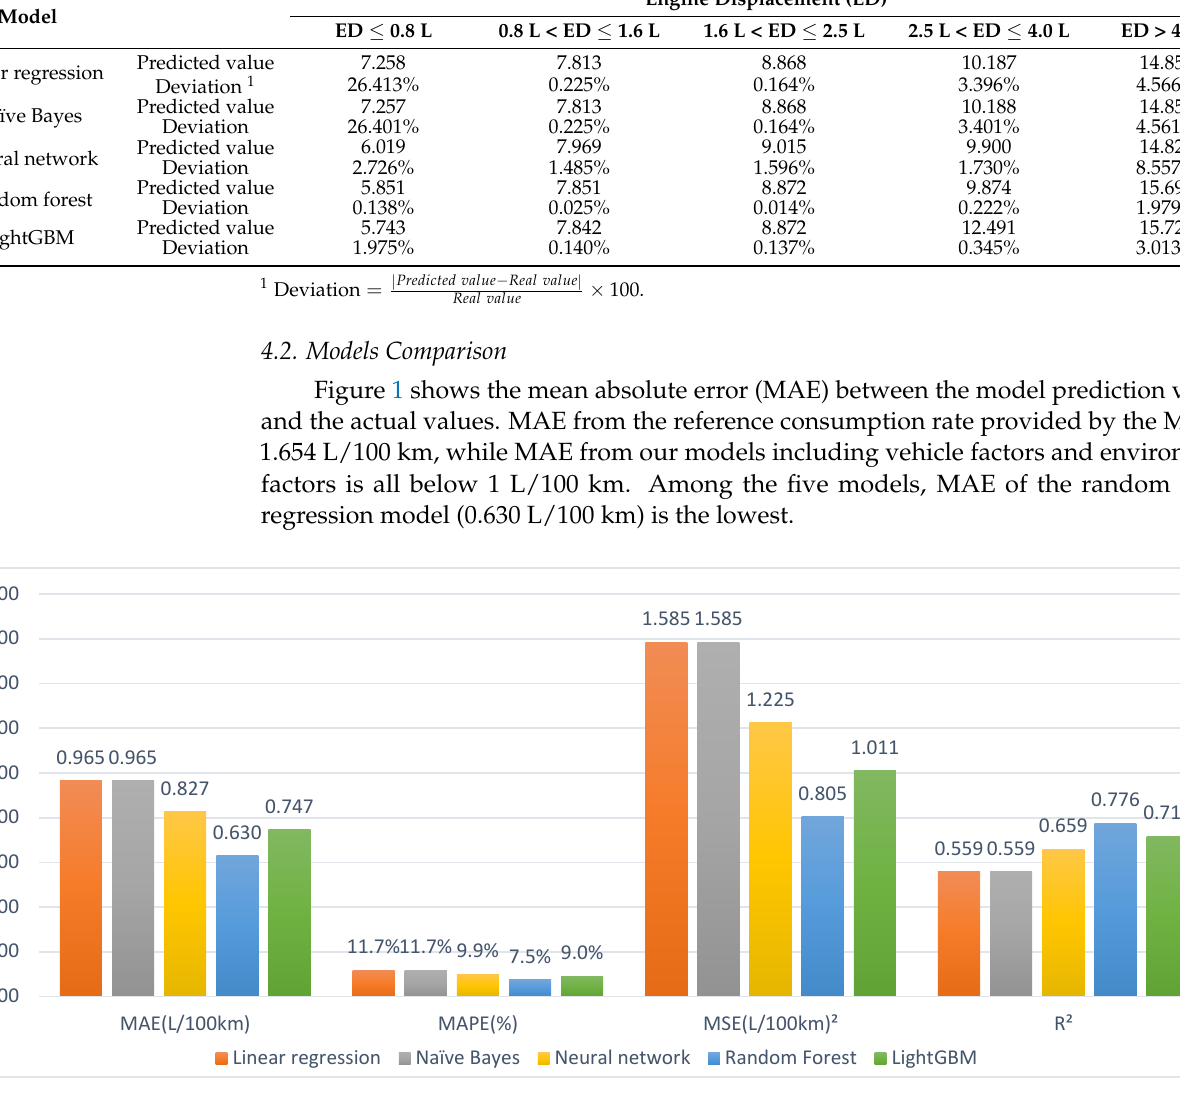
Figure 1. Evaluation indicators of the five models.